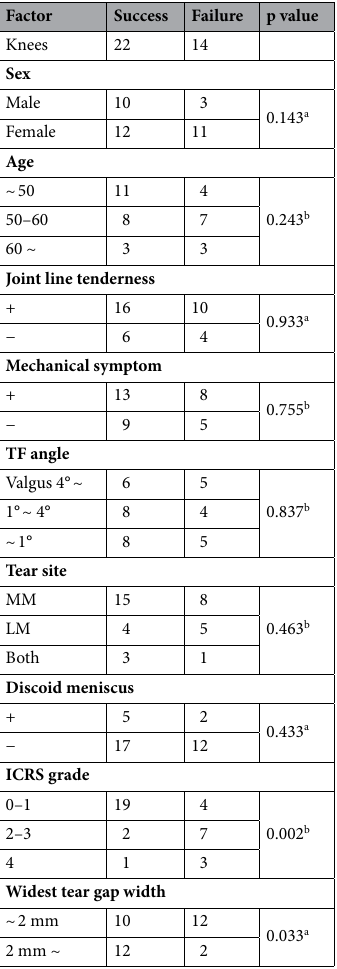
Table 3. Single variable analysis results of factors to the success of arthroscopic surgery. a Fisher’s exact test. b Pearson’s chi-square test. TF angle tibiofemoral angle (joint alignment on the simple